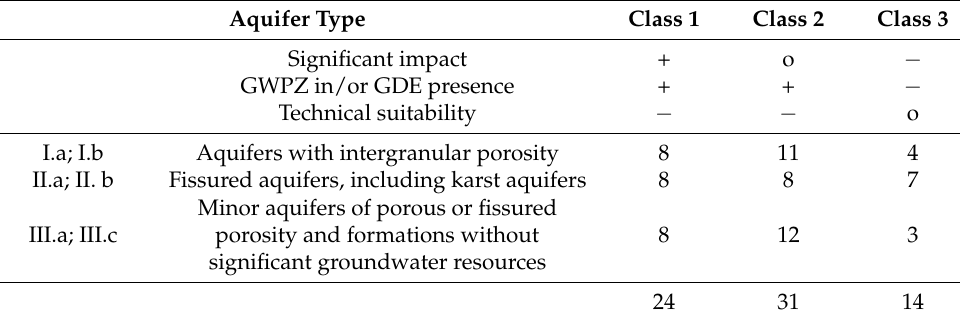
Table 5. Classification of landfills based on the conceptual model